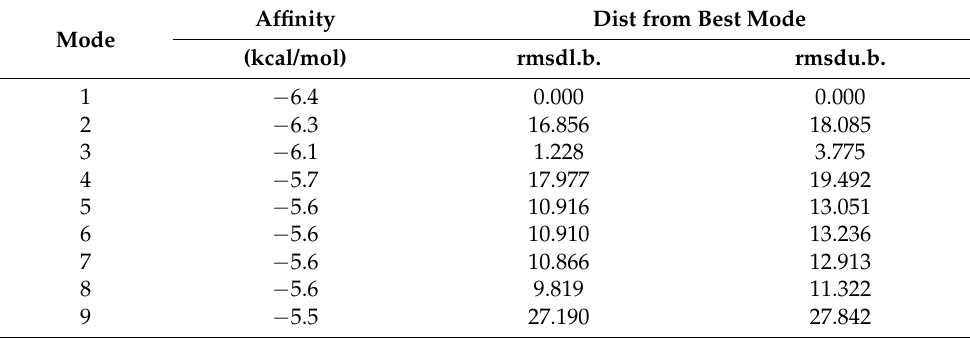
Figure 1. Molecular docking of gallic acid (GA) to the P2X7 receptor. The simulation modeling of GA docking to the P2X7 receptor was performed by a computer. The molecular docking prediction of GA to the P2X7 receptor was performed using AutoDock 4.2. The front view ( A ), top view ( B ) and enlarged views ( C , D ) indicate the perfect match for GA to interact with the P2X7 receptor. Table 1. Molecular docking score of P2X7 receptor docking and gallic acid.